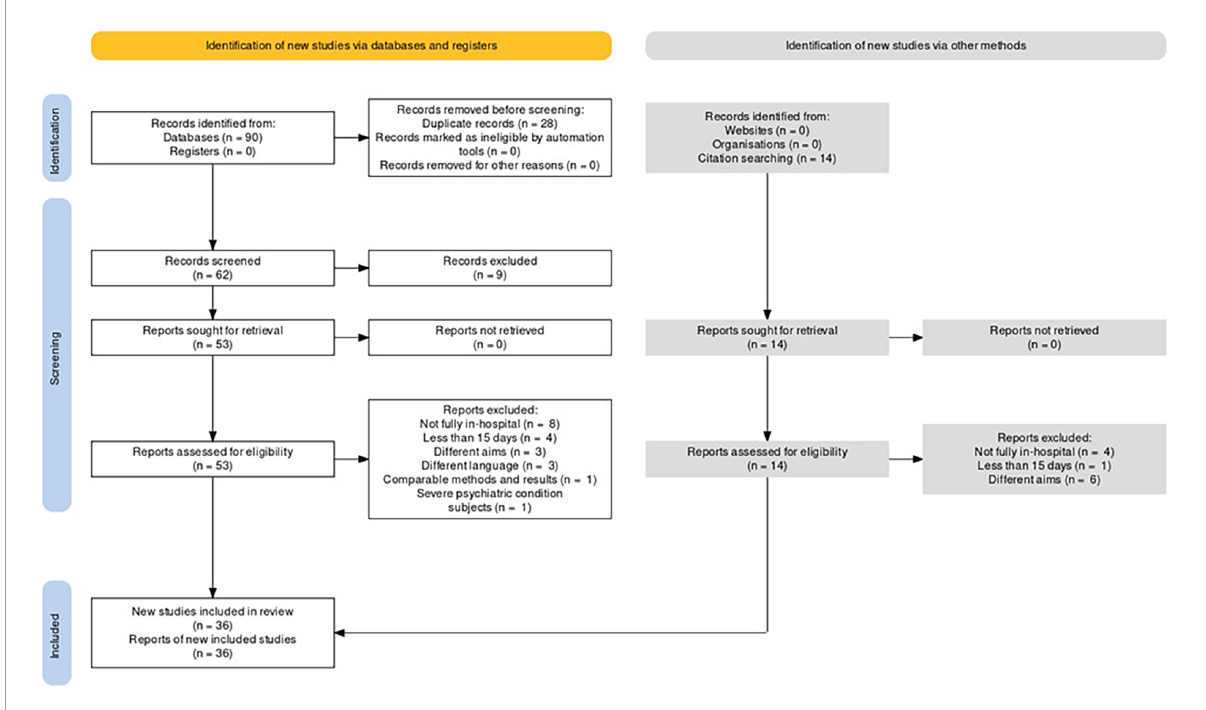
FIGURE1 Flow chart according to PRISMA 2020